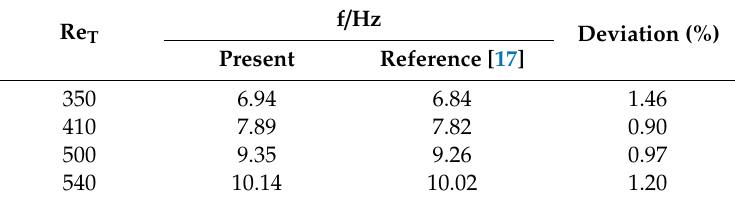
Table 4. Comparisons of the oscillation